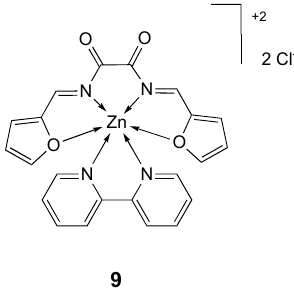
Figure 6. Structure of the zinc complex 9 .